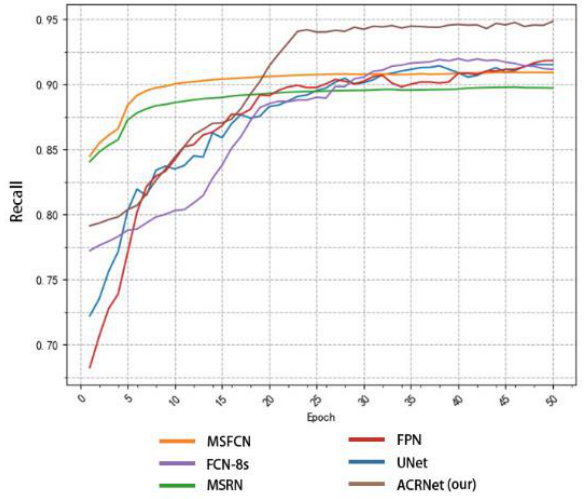
Figure 8. Variation of the accuracy of each model with the number of training epoch.